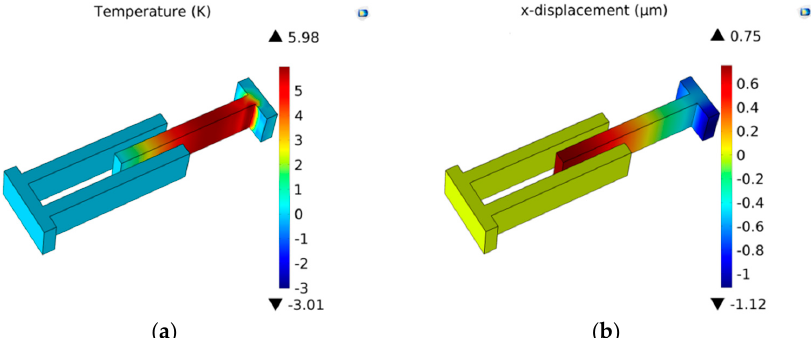
Figure 7. Distribution of temperature and variation of displacement for electrostatically actuated longitudinal vibration: ( a ) temperature displacement; ( b ) displacement variation.